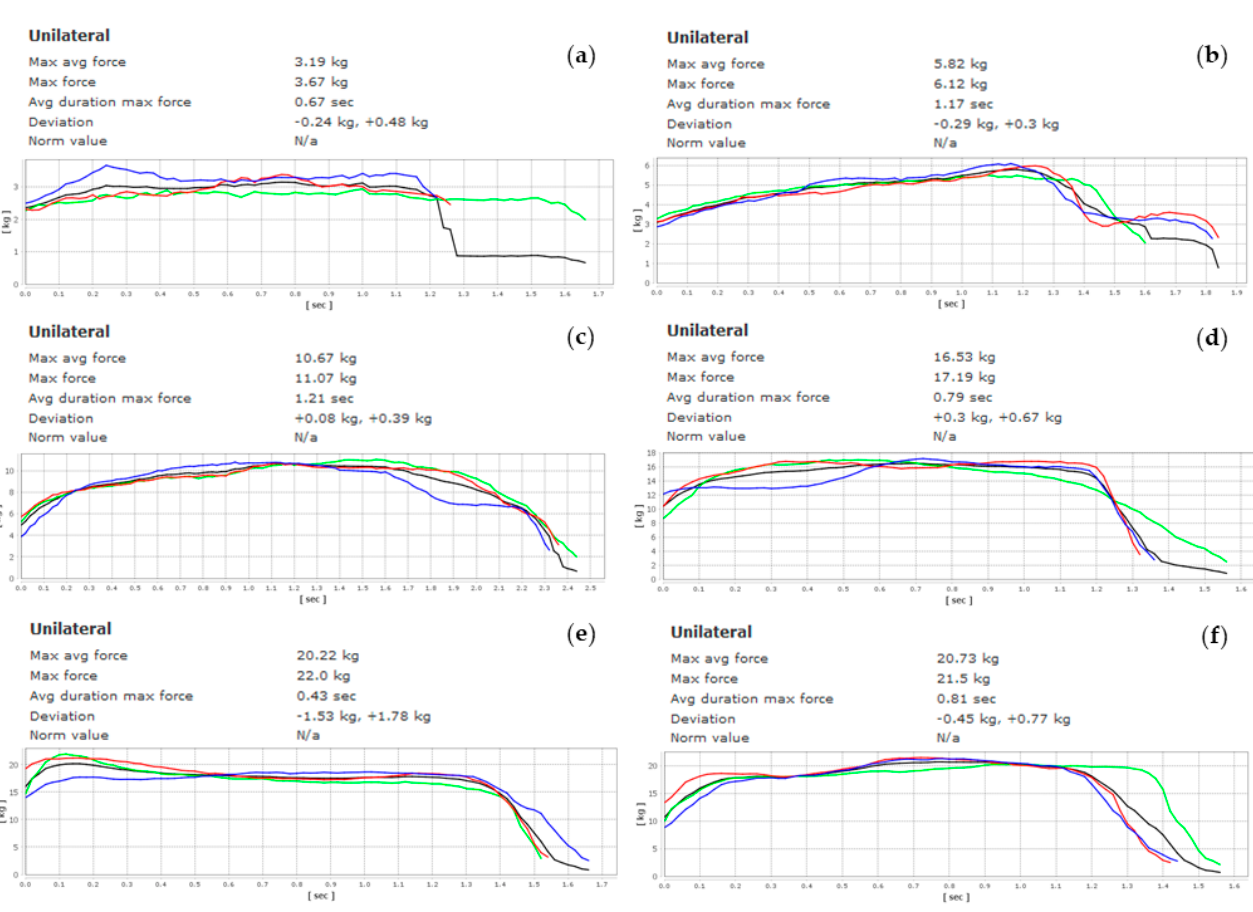
VAS, visual analogue scale; ROM, range of motion °.